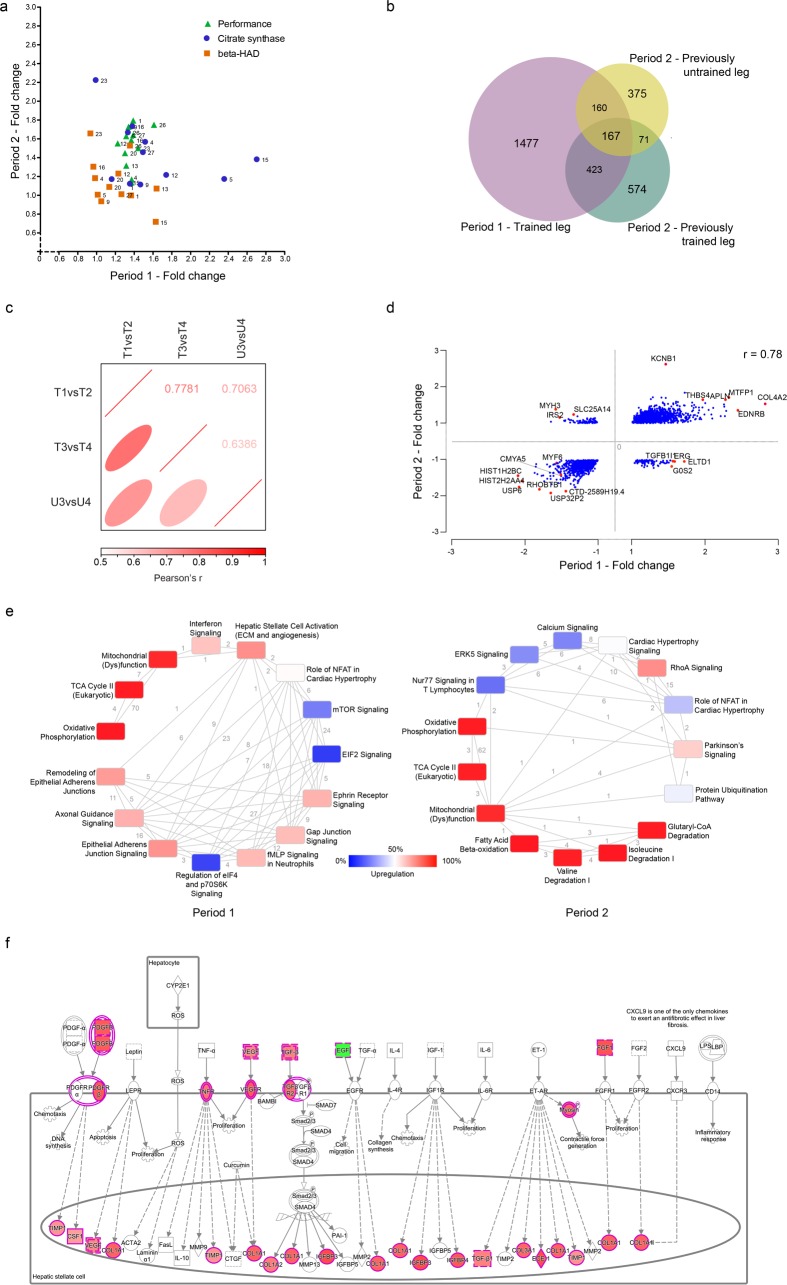
Comparing intra-individual effects of a repeated environmental training stimulus.a) Correlation of individual fold changes for performance (green triangles), citrate synthase activity (blue circles) and β-HAD activity (orange squares) for the leg trained in Period 1 (T1 vs T2) and the same leg trained in Period 2 (T3 vs T4) for the 12 individuals that completed both training periods. b) Venn diagram comparing the gene changes in the leg trained in Period 1 with both legs trained in Period 2. Data is based on all available sequencing data from biopsies of the common 12 individuals. c) Pearson’s correlation between the absolute fold changes of the significant genes differentially expressed in Period 1 (T1 vs T2) with the absolute fold changes of the same genes in Period 2, for T3 vs T4 and U3 vs U4, respectively. All correlations were significant (p<0.0001) d) XY-plot of the fold changes of the same genes as in (c) for the leg trained in Period 1 (T1 vs T2) and the same leg trained in Period 2 (T3 vs T4). Examples of genes are highlighted in red with gene names. e) Ontology analysis of the differentially expressed genes in Period 1 (left, T1 vs T2) and the same leg in Period 2 (right, T3 vs T4) for 12 individuals. Top 15 categories based on significance according to IPA are shown. The number at each line represents the number of common genes between the two categories connected by the line. Square color indicates the percentage of upregulated genes among the significant differentially expressed within that category. f) Example of a network that was uniquely enriched in Period 1 (T1 vs T2). Red color indicates an increased expression of that gene or group of genes with training, while green color indicates a decrease.